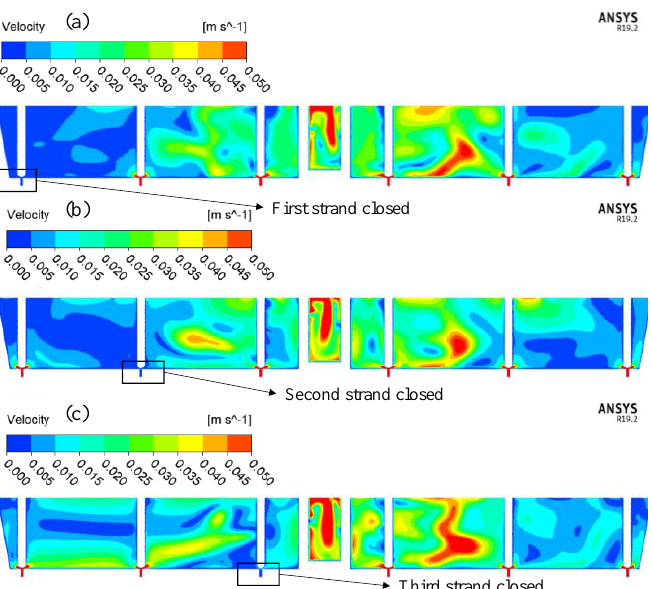
Figure 7. Outlet section velocity cloud of liquid steel in tundish for fewer strands casting: scheme 1 ( a ); scheme 2 ( b ); scheme 3 ( c ).